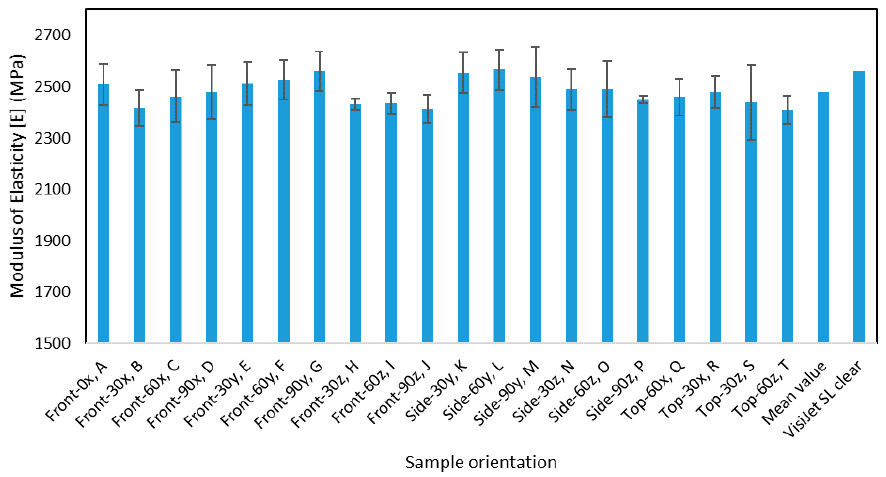
Figure 12. The modulus of elasticity for the di ff erent orientations.